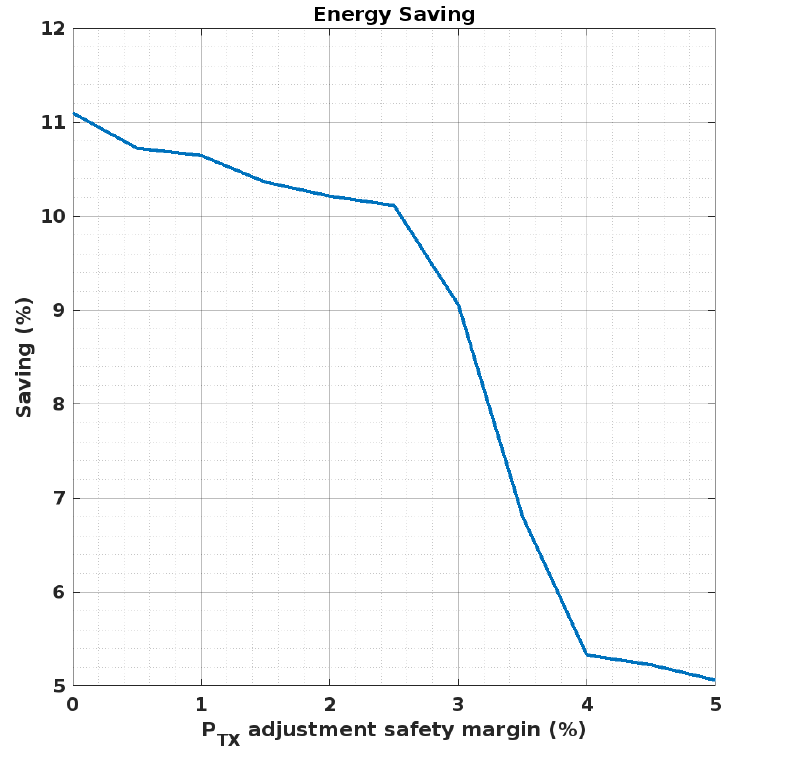
Figure 3. Power adjustment safety margin versus energy